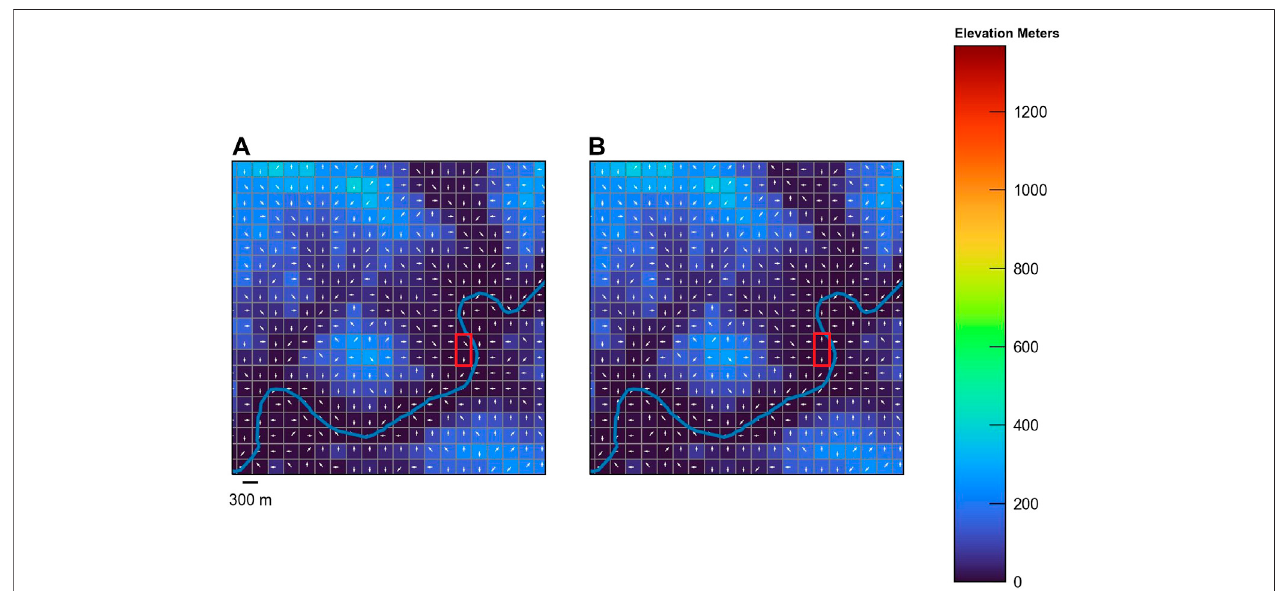
FIGURE 3 | Maps showing calculated fl ow direction vectors for a part of the Russian River watershed (inset box in Figure 1B ) with a low relief valley bounded by steep topography. The modi fi ed Dijkstra Algorithm (Dijkstra, 1959) produces fl ow direction vectors that generally follow the NHDPlus streamline (blue; Buto and Anderson,2020) (A) .Theredboxshowsaproblemsectionofthewatershedthatcontainsdigitalartifacts.Streamdirectionvectorswithintheredboxdraindownstream in (A) . The red box in (B) shows stream direction vectors that diverge from the watershed drainage pattern and create a condition where the fl ow direction array does provide a continuous drainage path.